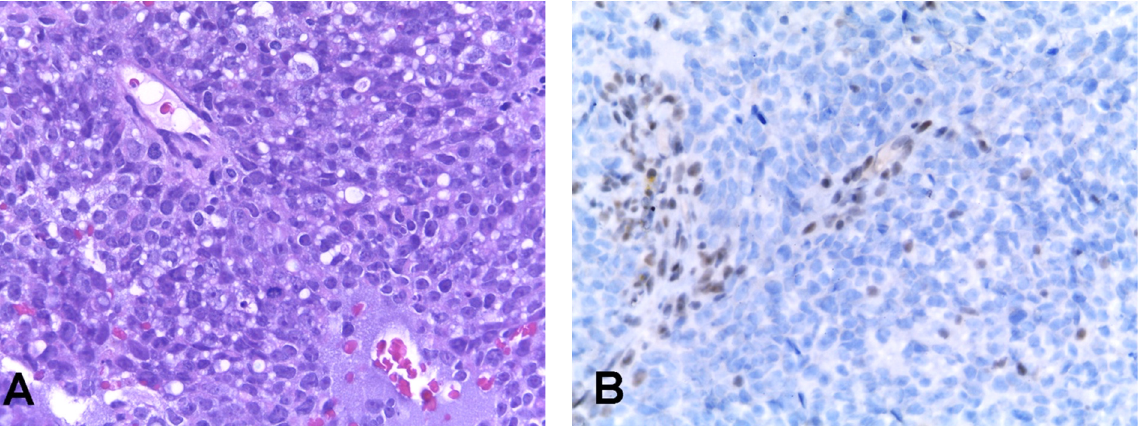
Figure 3. SMARCB1 deficient carcinoma. The tumor consists of a relatively uniform population of undifferentiated basaloid cells organized in solid sheets ( A ). Immunohistochemistry shows com- plete loss of INI1 in neoplastic cells, while nuclear positivity is retained in stromal cells ( B